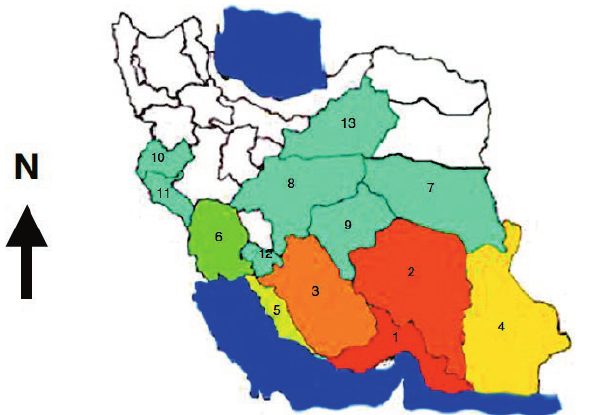
Figure 1. The provinces that are under date palm cultivations in Iran. Numbers 1- 13 are: Hormozgan, Kerma, Fars, Sistan & Bal- uchestan, Bushehr, Khuzestan, South Khorasan, Isfahan, Yazd, Ker- manshah, Eilam, Kohgiluie and Boier-Ahmad, and Seman, respec- tively (Hajian 2007, Hajian et al.